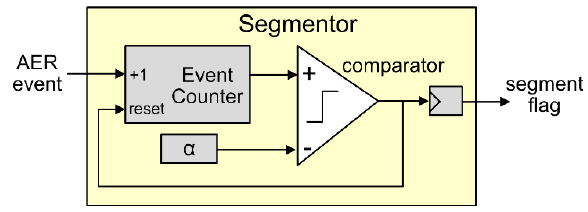
Figure 3. The circuit of the segmentor block .